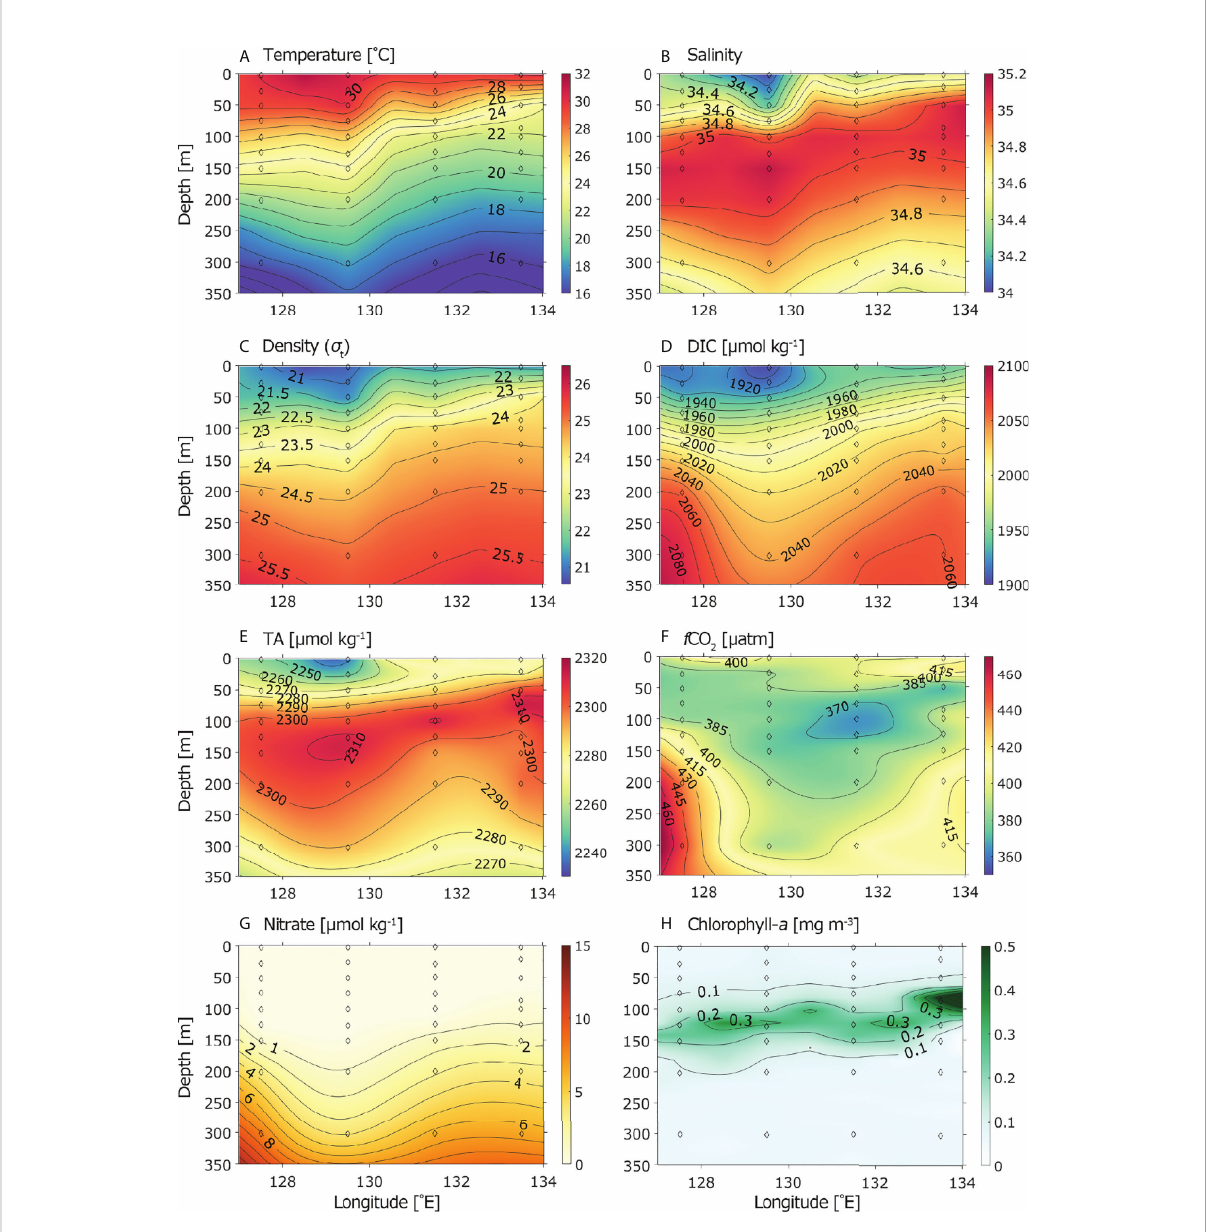
FIGURE 3 Vertical distributions of temperature (A) , salinity (B) , seawater density (C) , DIC (D) , TA (E) , fCO2 (F) , nitrate (G) , and chlorophyll-a (H) along the 19.5°N transect. Open diamonds indicate sampling